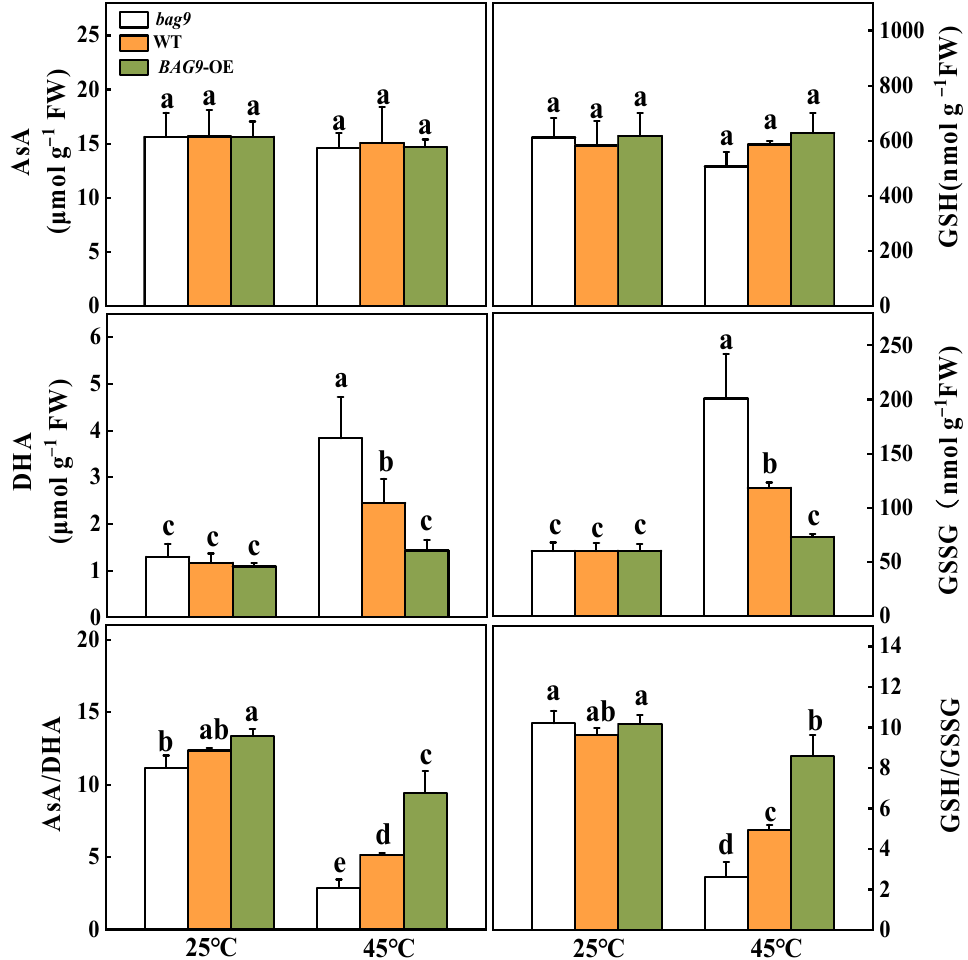
Figure 6. Effects of heat stress on AsA and GSH pools in tomato leaves. Data were the means ± SD of three biological replicates. Different letters represented significant differences ( p < 0.05) according to Tukey’s test. WT, wild type; BAG9 -OE, BAG9 overexpressing